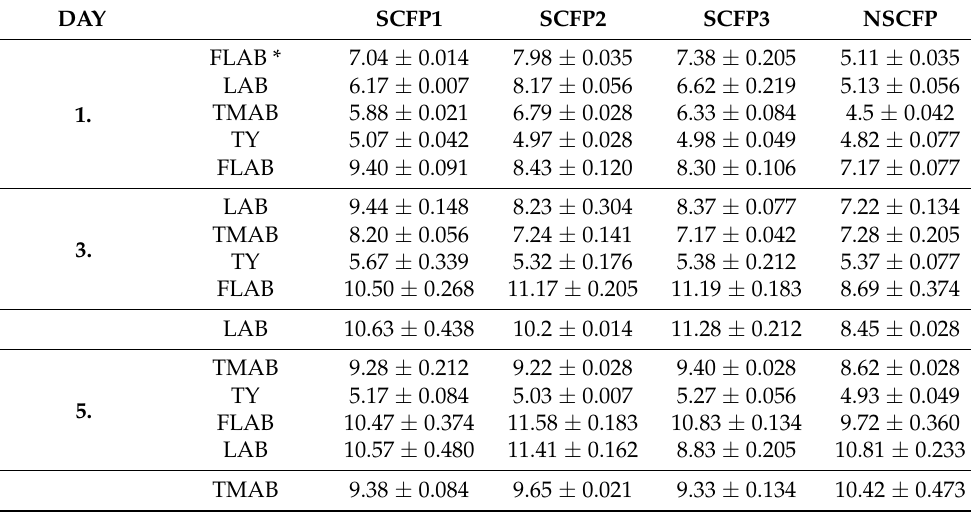
Table 5. FLAB, LAB, TMAB and TY values of bee bread during storage (log cfu g − 1